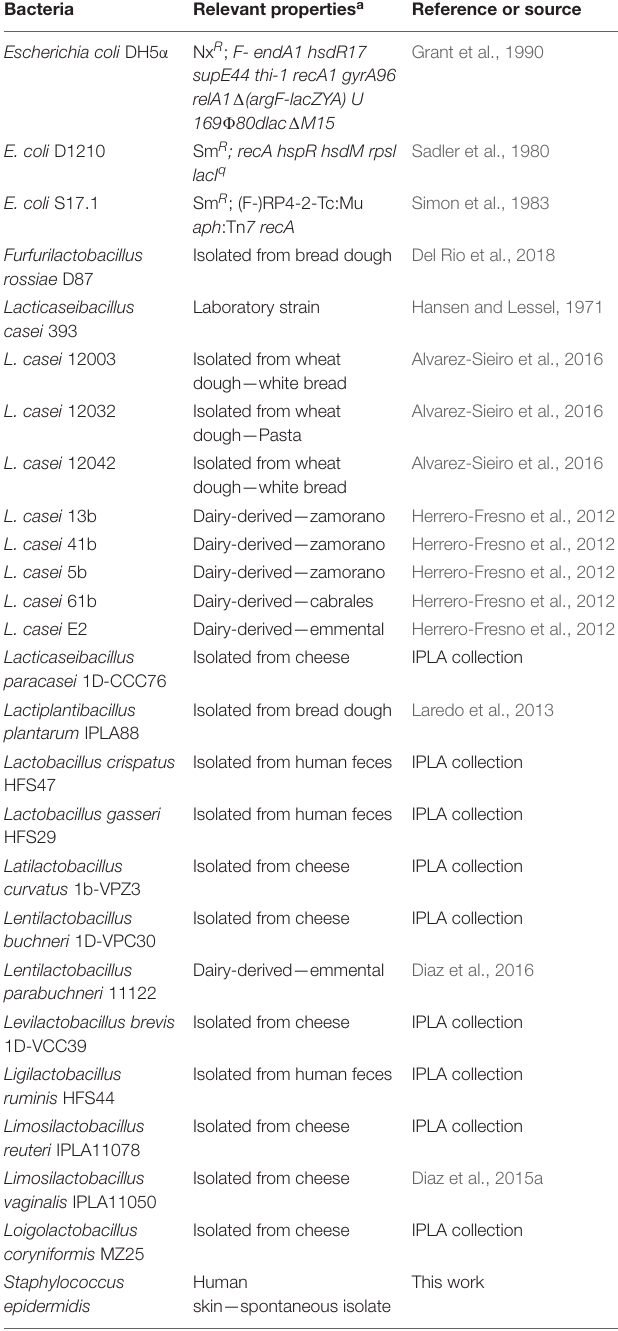
TABLE 1 | Bacterial strains used in the present